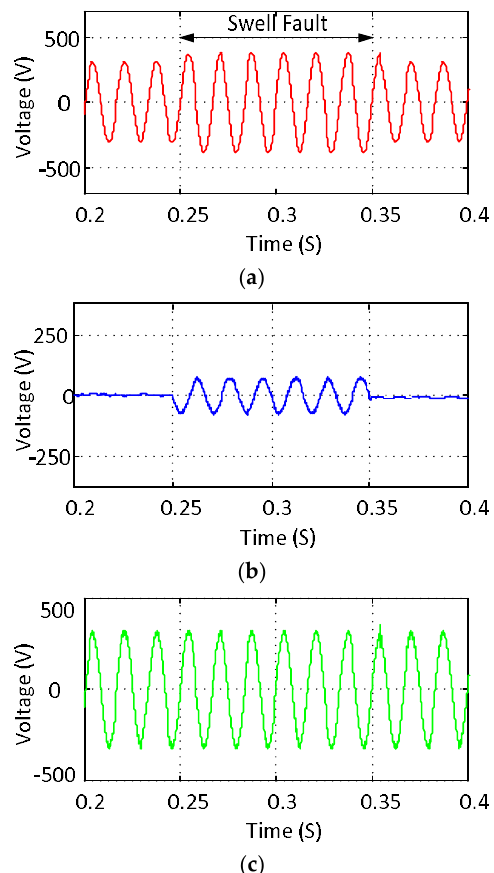
Figure 16. Simulation results of the proposed DVR at 25% voltage swell compensation: ( a ) line voltage, ( b ) output voltage of the converter, ( c ) load